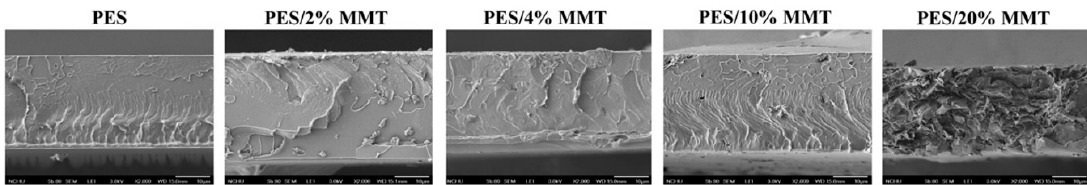
Figure 14. Relative CO 2 /CH 4 selectivity results for MMMs [124].